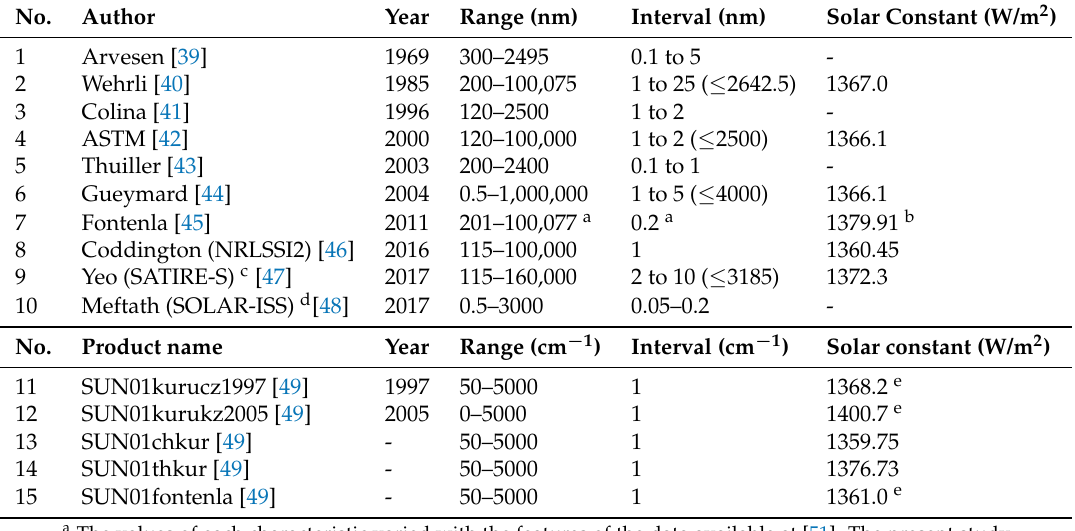
Table 2. List of the spectral solar irradiances. Nos. 11–15 are based on spectral solar irradiances available at MODTRAN 5.2 [49,50].